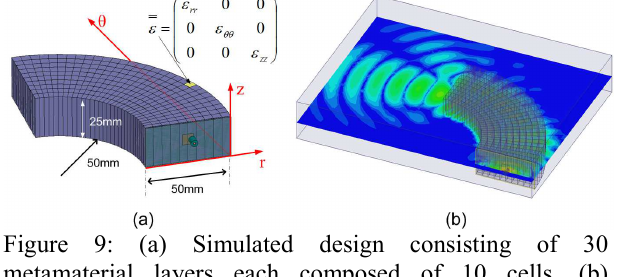
Figure 9: (a) Simulated design consisting of 30 metamaterial layers each composed of 10 cells. (b) Calculated energy distribution at 10 GHz.